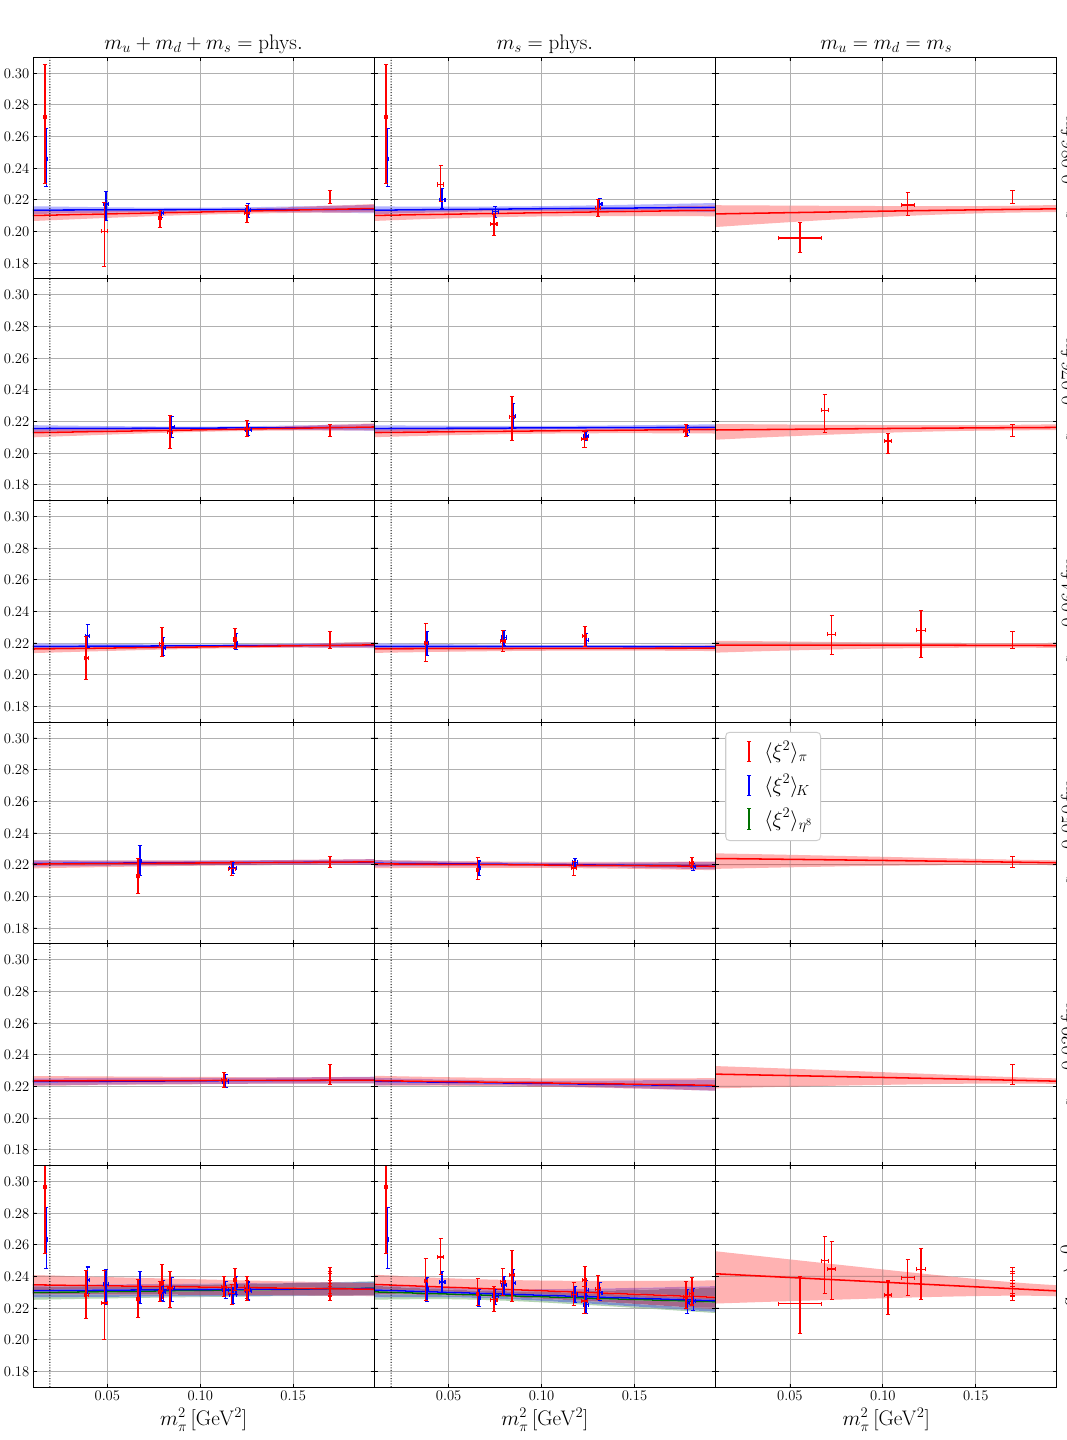
, defined in eq. (2.16a), plotted (top ξ 2 (cid:31) (cid:30) M